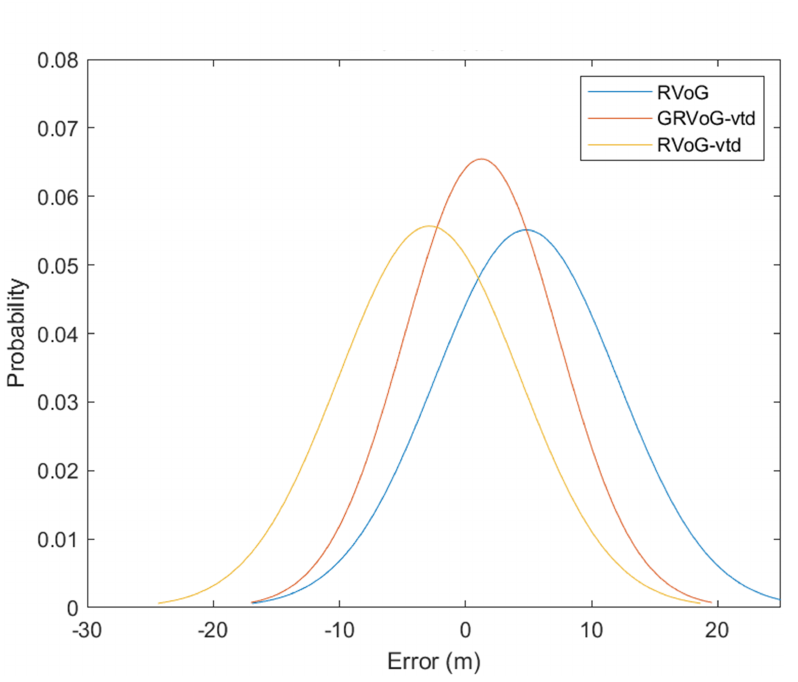
Figure 15. The error distributions of employed algorithms compared to LVIS RH100 heights.